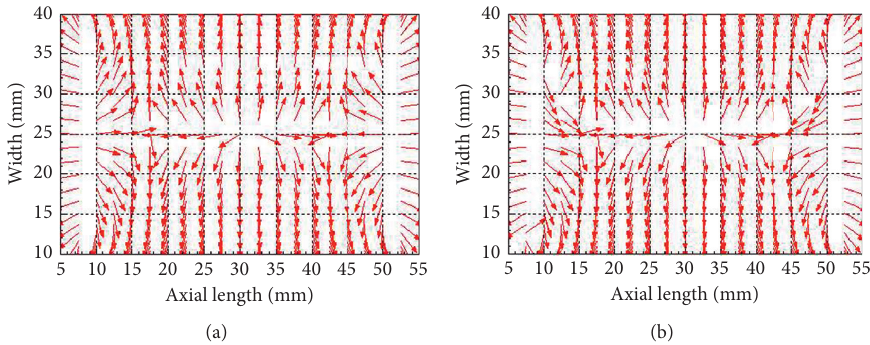
Figure 10: Friction slip field in the contact area. (a) Friction slip ( P � 1GPa). (b) Friction slip ( P �